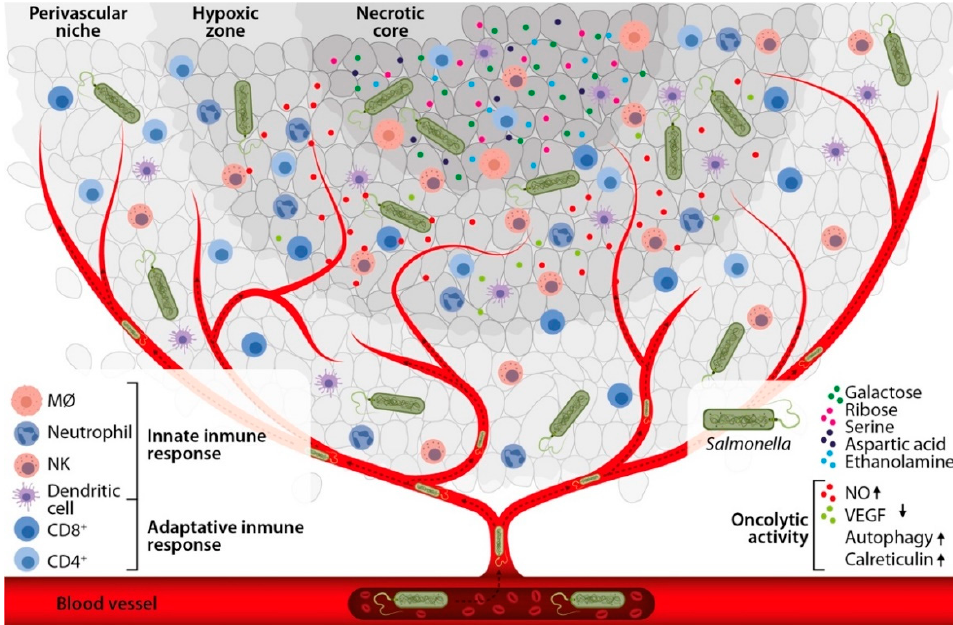
Figure 1. Tumor selectivity and inherent antitumor activity of Salmonella enterica . After Salmonella enterica enters the host through the mucosas or intravenously, it can specifically target tumor tissue due to hypoxia, acidity, necrosis, suppressed immune response, and the presence of chemoattractants of the bacterium in the tumor microenvironment. Subsequently, Salmonella enterica , activates inherent antitumor mechanisms, including its oncolytic activity per se, and the induction of the innate and adaptive immune responses.